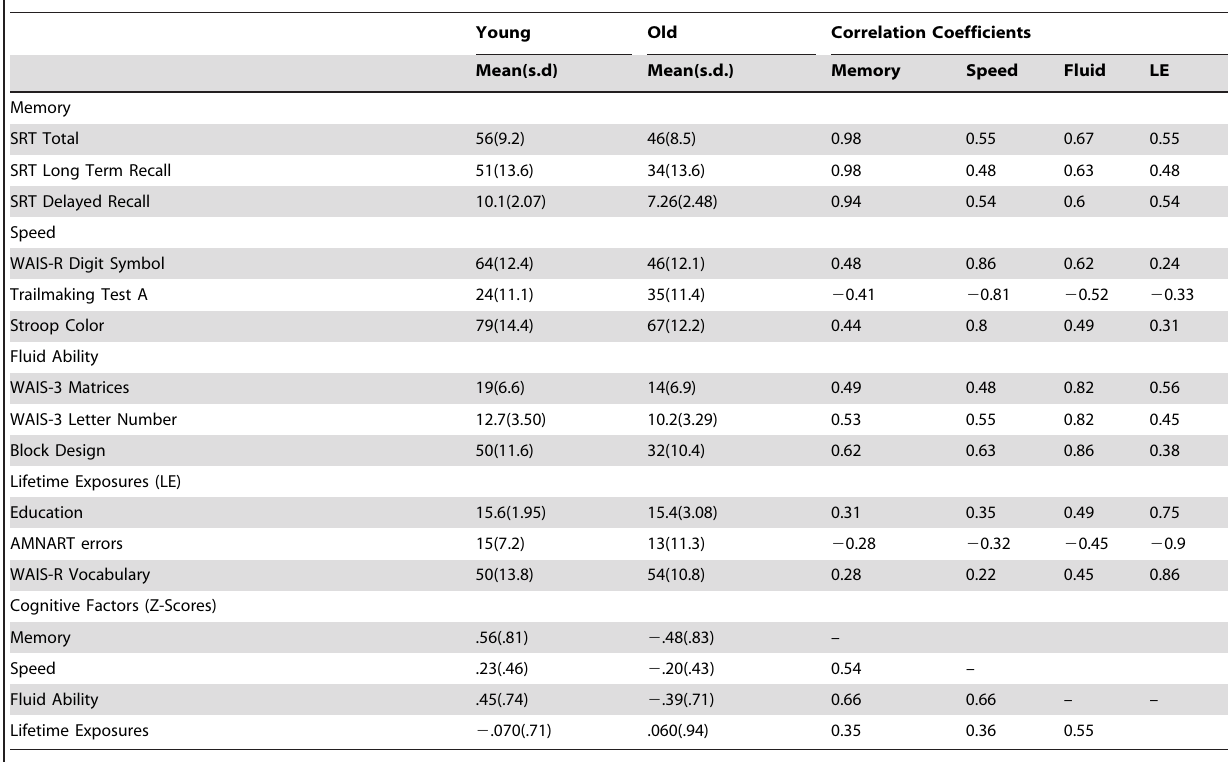
Table 1. Composite factors and their